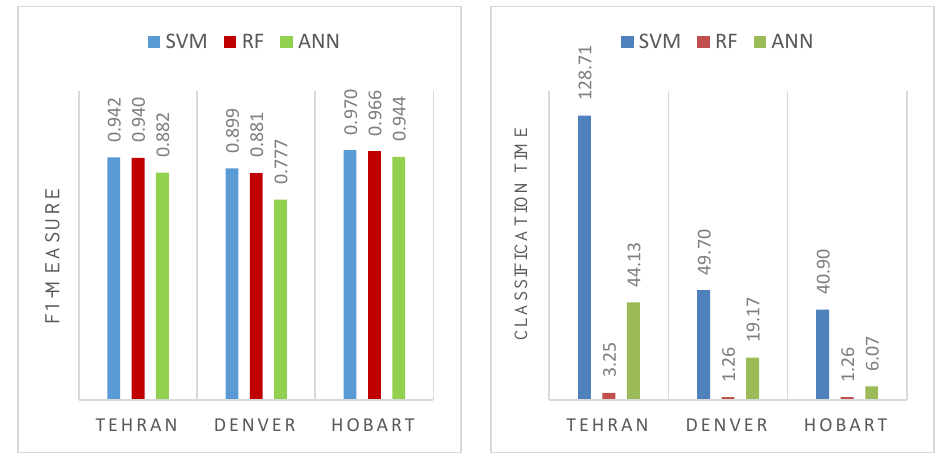
Figure 4. F1-measure values and classification time for classification of 137 feature datasets from images Tehran, Denver, and Hobart.